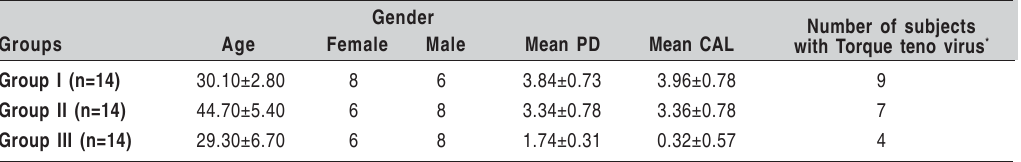
Table 1. Study population characteristics (n=42)